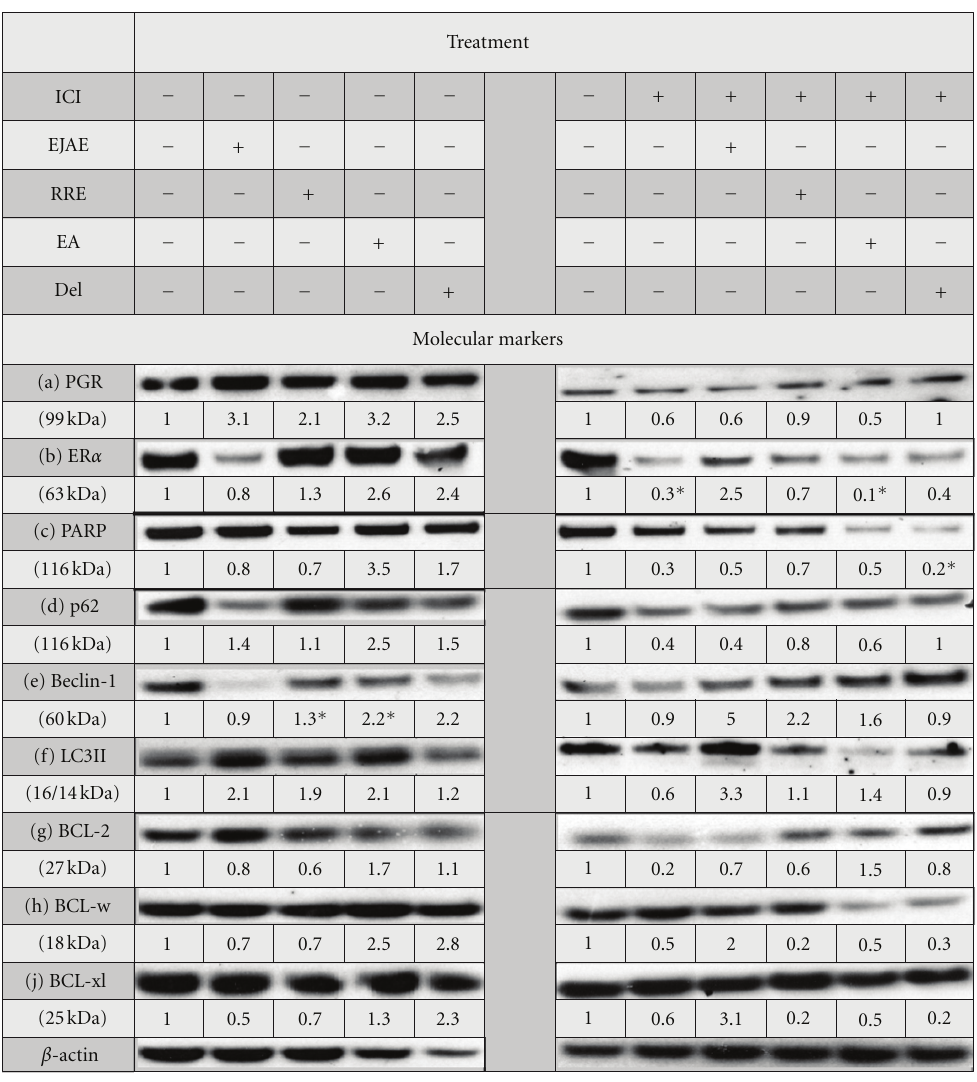
Figure 4: E ff ect of berry extracts and polyphenols on the expression of nuclear receptors and cell-death markers in ICI-sensitive (LCC1) Cell Lines. Biomarker analysis results from 3d treatment of berry extracts and polyphenols. Data represented as fold change over the vehicle. Extract only treatment was normalized to nontreated cells (first lane). Extract +ICI was normalized to the appropriate vehicle treatment (first lane). Vehicle treatment contained 0.01% EtOH and 0.1% DMSO. Concentrations of treatments were as follows: ICI = 1nM; EJAE = 0.1 μ g/mL; RRE = 1 μ g/mL; EA = 1 μ M; DEL = 1 μ M. Concentration of extract used showed the most significant reduction in cell proliferation of LCC1 cells after 6d treatment. Each extract or polyphenol used for treatment was diluted 1000-fold from stock concentration. ∗ designates a significance of P ≤ 0 . 05 compared to vehicle